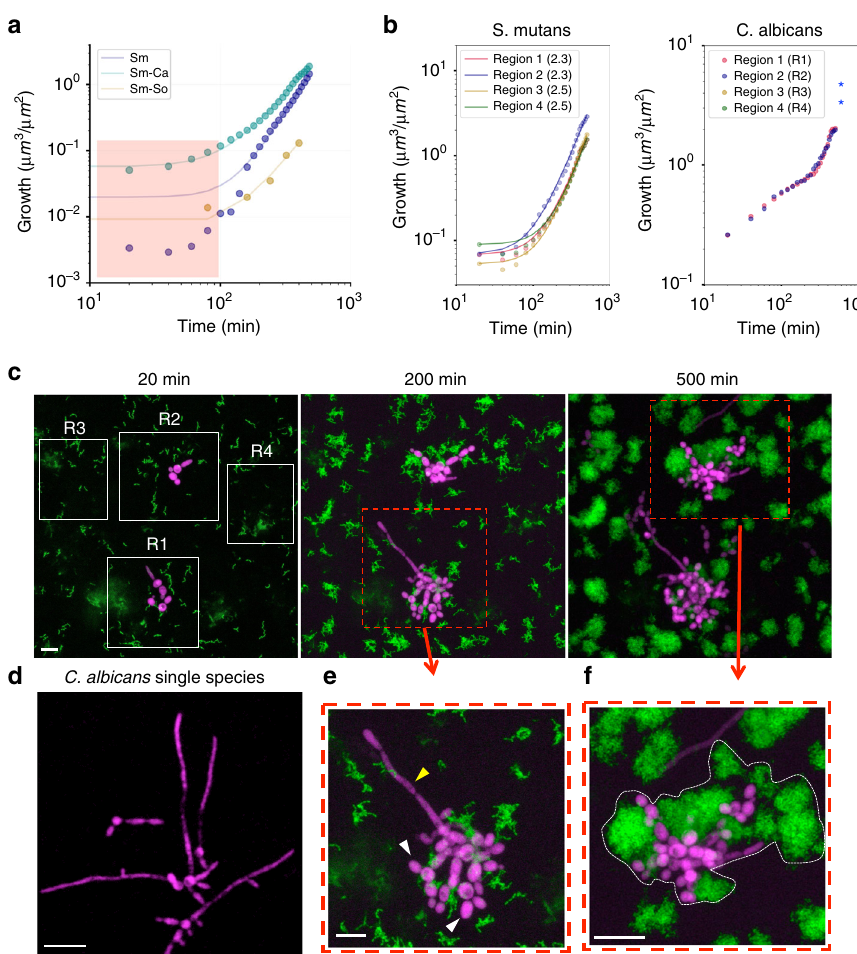
Fig. 7 Growth dynamics in mixed communities. a Growth curve (dots) and fi tting (lines) for S. mutans in single-species bio fi lm (Sm; dark purple dots), in cross-kingdom bio fi lm (Sm-Ca; green dots), and in mixed-bacterial species bio fi lm (Sm-So; yellow dots). b Localized S. mutans and C. albicans growth curves at distinct sites (R1, R2, R3, and R4 as shown in c ). Exponent b values are in parenthesis. c Z-projection (max intensity) of the CLSM images stack showing growth of S. mutans and C. albicans on HAD, with bacteria (green) and fungi (purple) channels, ( e , f ) zoom-in images of S. mutans superstructures formed in the presence of C. albicans (also highlighted by dotted-white line in f ). d Z-projection of the CLSM image of C. albicans single-species bio fi lms. Scale bars indicate 10 µ m. Source data are provided as a Source Data fi